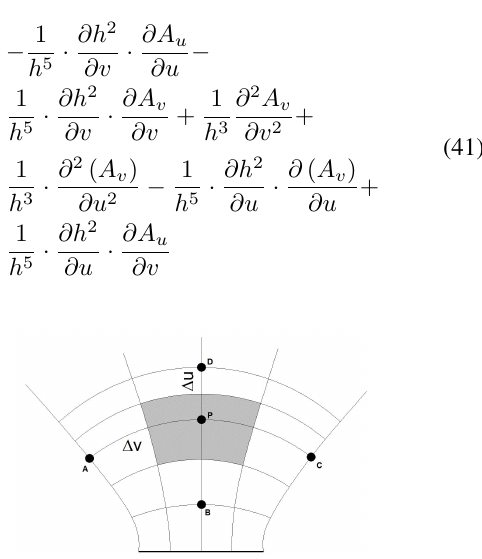
Figure 9: Internal point of the elliptic cylindrical coordi- nates (grid TE